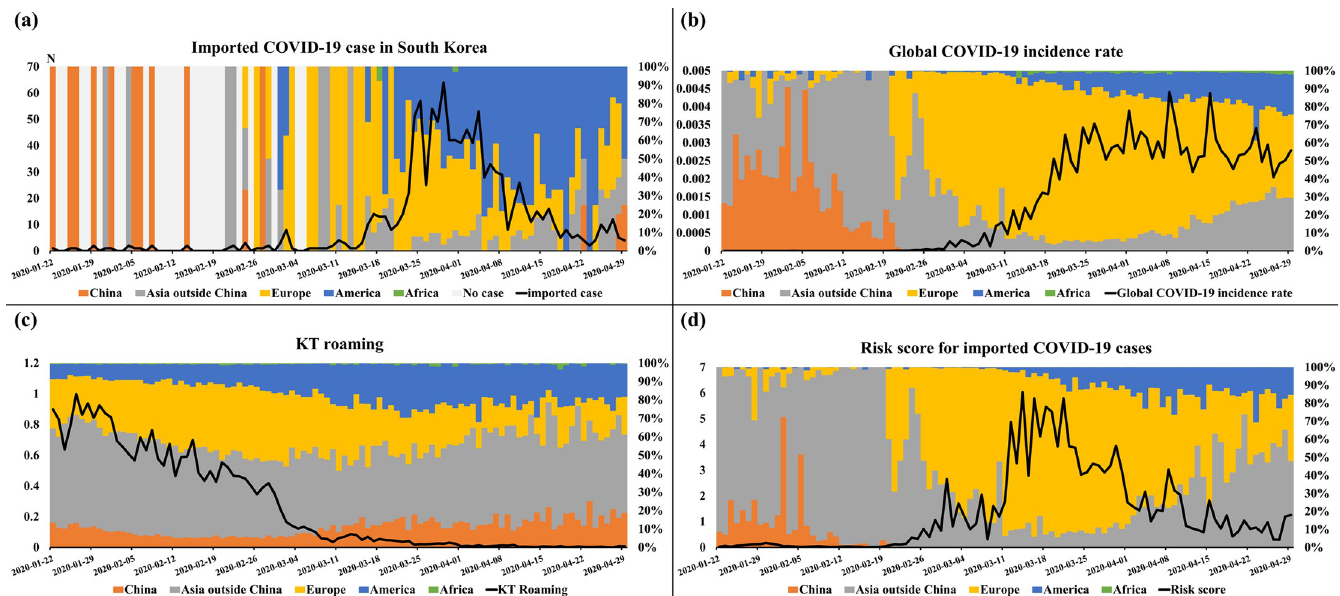
Fig 1. Imported COVID-19 cases in South Korea. (A) The time-series data of imported COVID-19 cases in South Korea. (B) Global COVID-19 incidence rate. (C) Korea Telecom (KT) roaming data. (D) Risk score of imported COVID-19 cases. The stacked vertical bar graph at 100% represents the ratio of daily values of countries categorized as China, Asia except China, Europe, America, and Africa. KT roaming data were converted to have a range from 0 to 1 by Min-Max